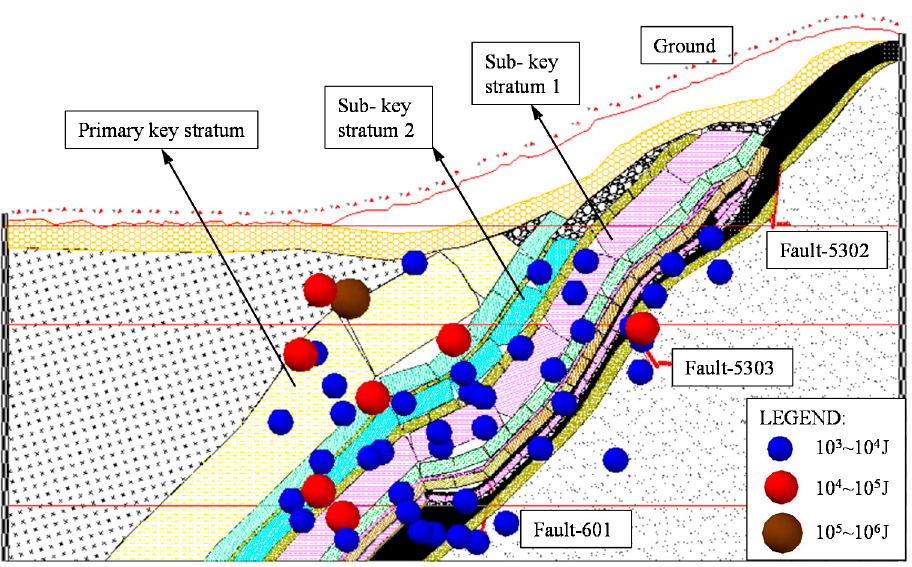
Figure 13. Localization map of recorded seismic events from 10 February 2017 to 10 March 2017. Energies 2020 , 13 , x FOR PEER REVIEW